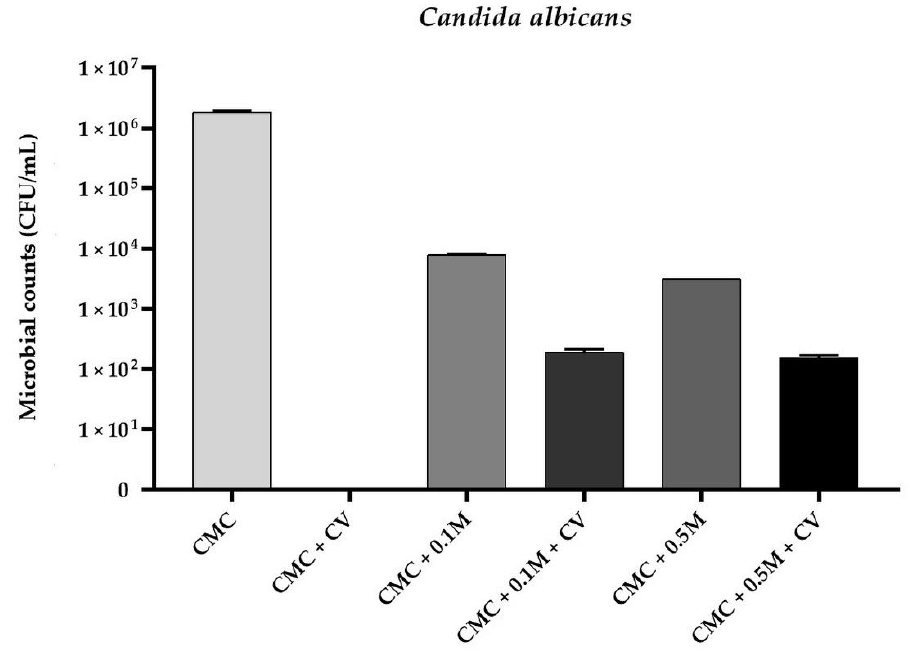
Figure 2. The effect of CMC-based neat and modified films on viability of Staphylococcus aureus cells.